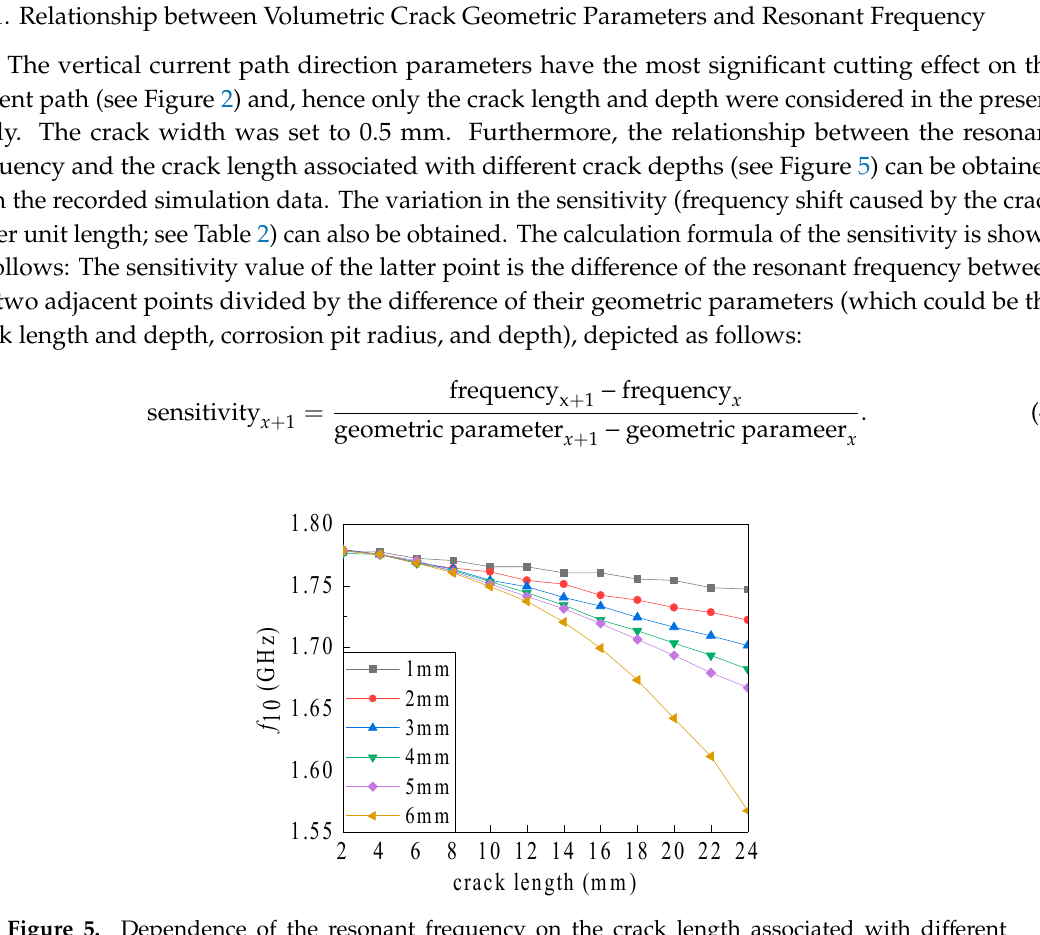
Table 2. Identification sensitivity of crack length.